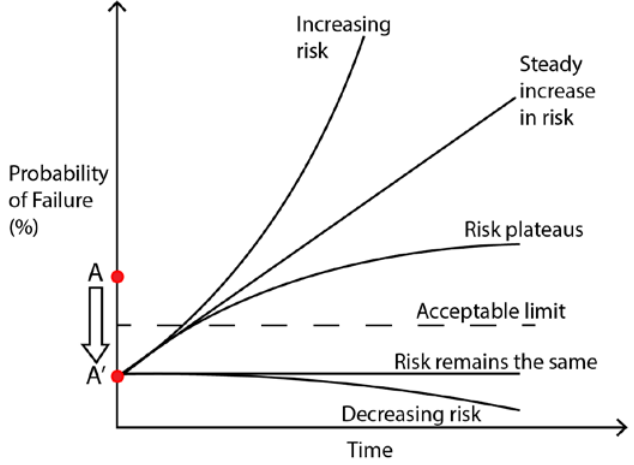
Figure 1. Changing probability of failure with time due to system changes.